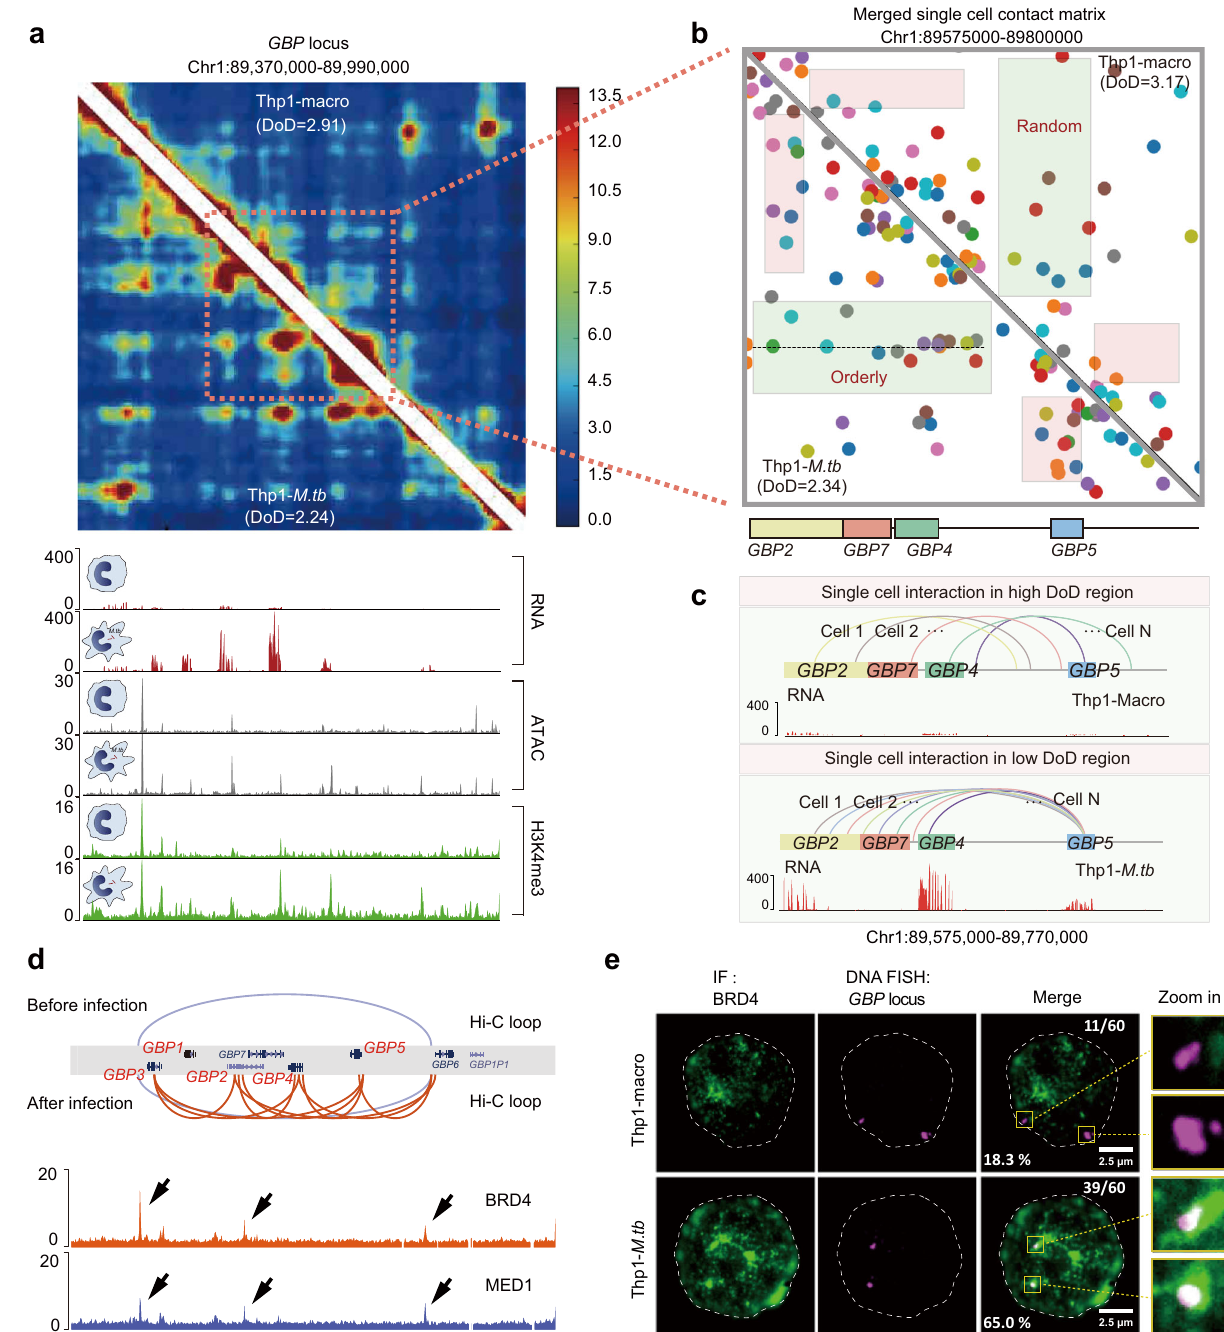
Fig. 4 | Remodeling of the chromatin con fi guration of guanylate-binding pro- tein (GBP) gene clusters. a Comparison of TAD DoD value, chromatin interaction matrices, chromatin loops, RNA expression levels, and epigenetic modi fi cations around the GBP loci in bulk cells before and after M.tb infection. b Comparing the single-cell chromatin contact differences using merged single-cell chromatin con- tact matrix. Each color of the dots in the matrix represents the chromatin contact fromthesamecell. c Single-cellchromatincontactsbetween GBP2 , GBP4 , GBP5 ,and GBP7 and RNA expression before and after M.tb infection. d Depiction Hi-C chro- matinloops beforeand after infection and BRD4and MED1ChIP-seq peaks around